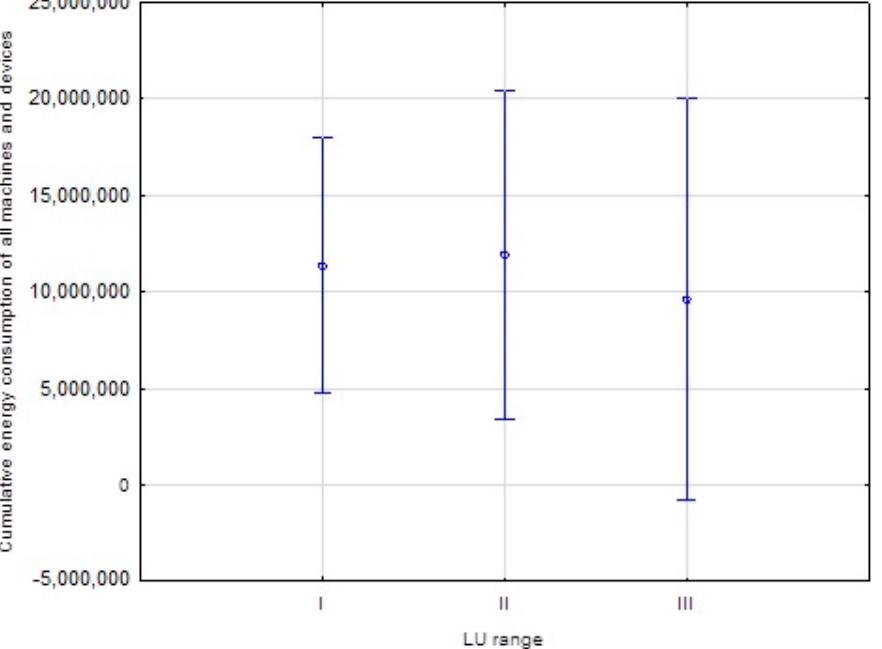
Figure 3. Dependence of cumulative energy intensities for various feed mixing and feeding technolo- gies on the LU number.